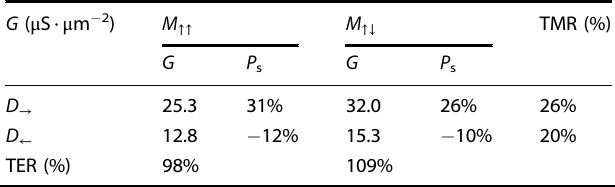
Table 1. Spin dependent conductance, TMR, TER and spin polarization ratio ( P s ) of the Co/HfO 2 /Co junction with 2 nm ferroelectric layer and asymmetric interface terminations at different oxygen displacements ( D ) and ferromagnetic ( M ) polarization